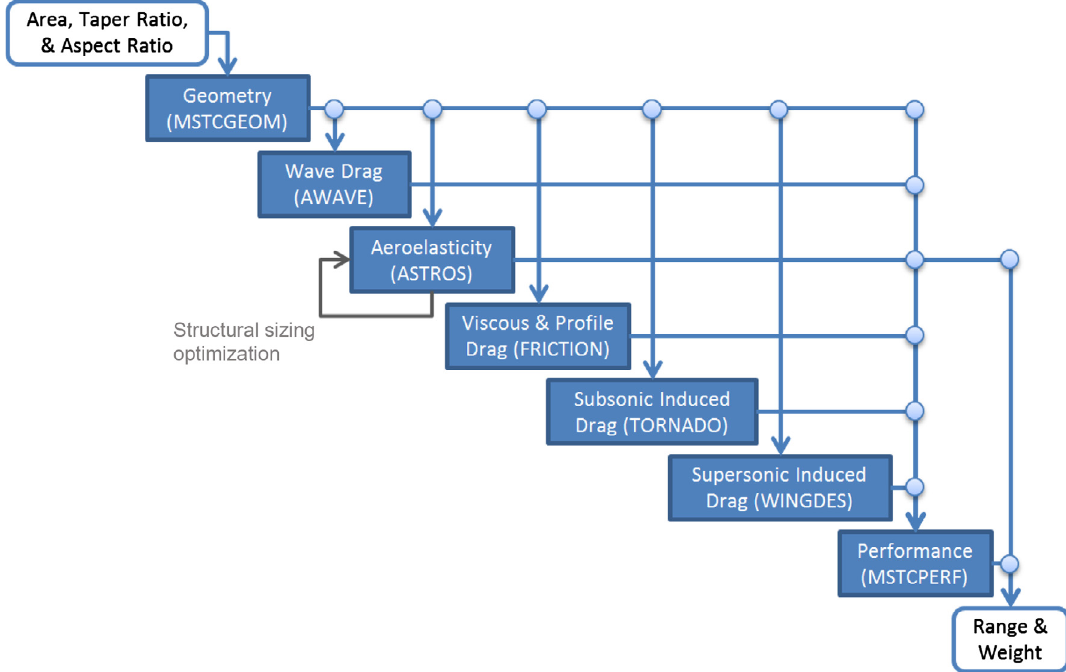
Figure 1. The ESAV MDA N 2 diagram includes geometry generation, an aerodynamic analysis, an aeroelastic analysis with structural sizing optimization, and a performance